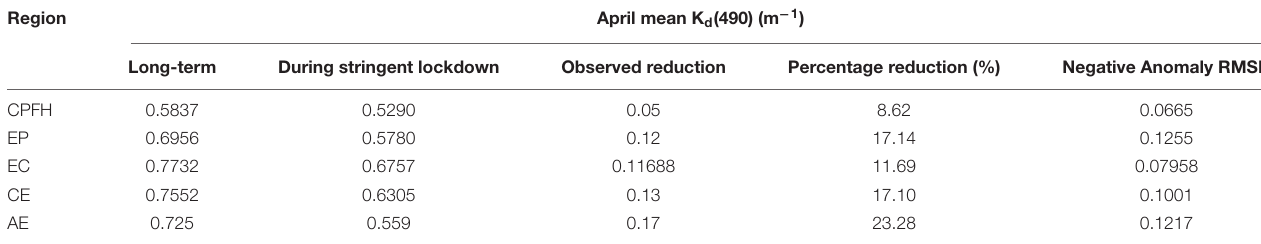
TABLE 2 | Statistical parameters of K d (490) for all prominent regions in the study area.